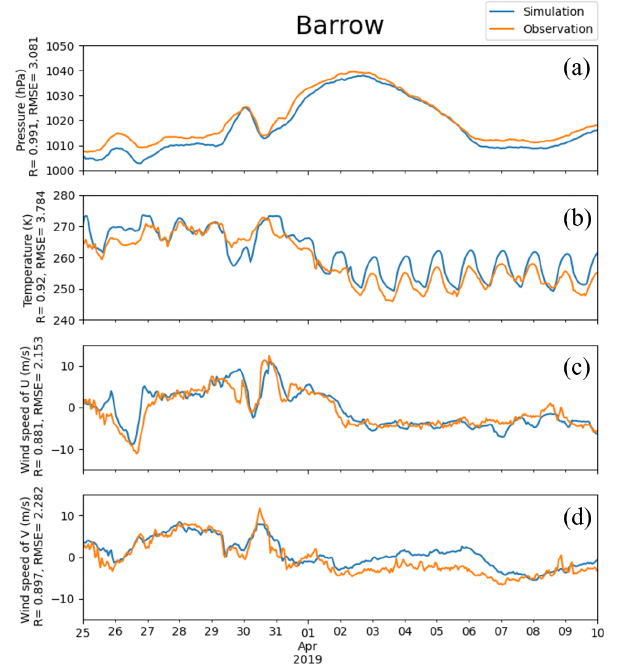
Figure 3. Pressure, temperature, and horizontal components of 10m wind ( U and V ) obtained from simulations and observations in Barrow from 25 March to 10 April 2019. The correlation coef- ficient R and the root-mean-square error RMSE are also presented on the vertical axis.